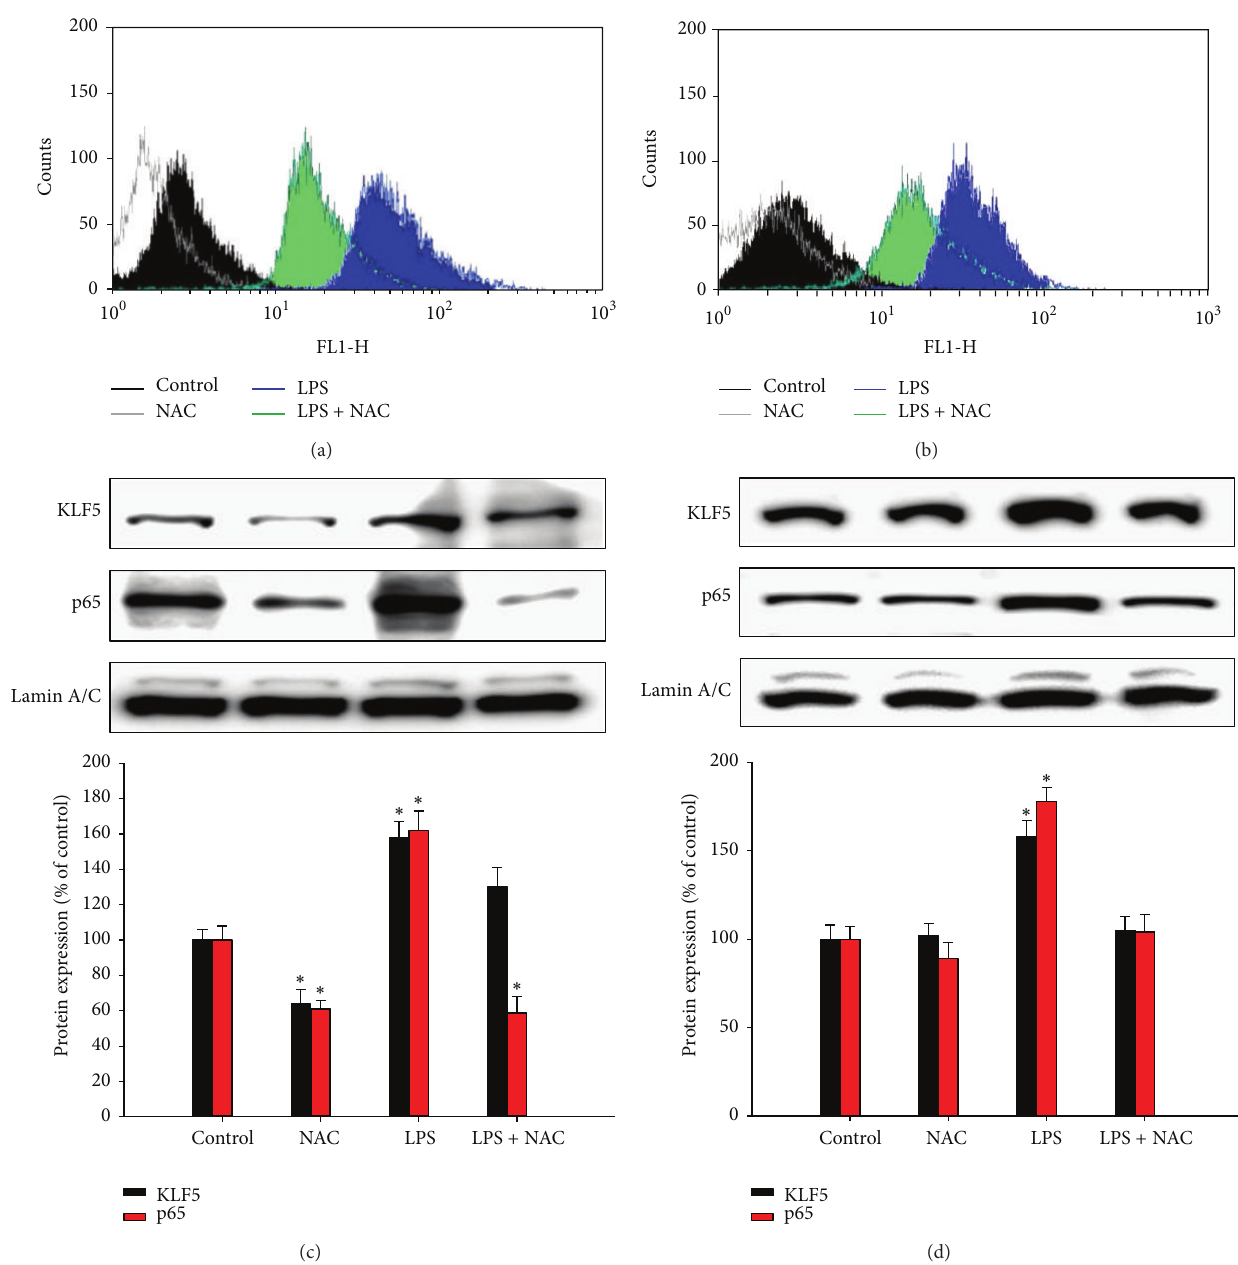
Figure 3: Effects of lipopolysaccharide (LPS) exposureon intracellular reactive oxygen species (ROS) levels and Kr¨uppel-like factor 5 (KLF5) and p65 expression in human bronchial epithelial cells. Cells from the (a) HBEC and (b) BEAS-2B lines were incubated with medium alone (control), N-acetylcysteine (NAC; 10mM), or 5 𝜇 g/mL LPS for 1h. Intracellular levels of ROS were measured using 2,7- dichlorodihydrofluorescein diacetate (DCFH-DA) assays and flow cytometric analysis. Histograms represent 3 independent experiments. Cells from the (c) HBEC and (d) BEAS-2B lines were incubated with LPS for 1.5 h, and nuclear protein expression was measured using western blotting. DCFH-DA assays indicated that 1h of LPS treatment increased intracellular ROS levels in the HBEC (a) and BEAS-2B (b) cell lines. LPS also increased KLF5 and nuclear factor-kappaB (NF- 𝜅 B) translocation in the HBEC and BEAS-2B cell lines. Pretreatment with NAC significantly reduced LPS-induced KLF5 and NF- 𝜅 B translocation in nuclear extracts of cells from the HBEC (c) and BEAS-2B (d) lines. Each bar graph shows summarized data (mean ± SEM) from 3 separate densitometry experiments after normalization to lamin A/C (an internal control). ∗ 𝑃 < 0.05 versus control